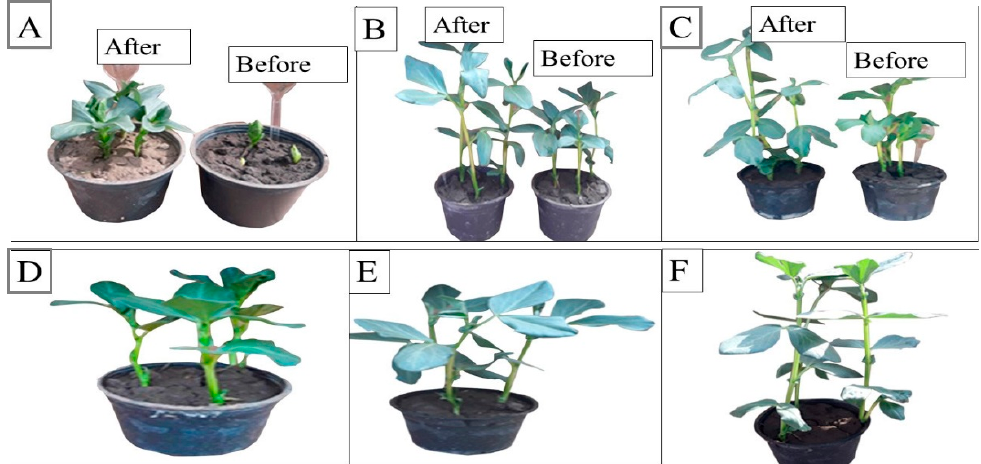
Figure 8. Phytotoxicity of MG and MG products on Vicia faba L. plants before and after biodegrada- tion using S. exfoliatus . ( A – C ) irrigation with MG before and after MG degradation by S. exfoliatus during 6 weeks of planting, ( A ) after 4 weeks, ( B ) after 5 weeks, ( C ) after 6 weeks. ( D – E ) control treatment after 4 weeks, ( E ) control treatment after 5 weeks, ( F ) control treatment after 6 weeks.